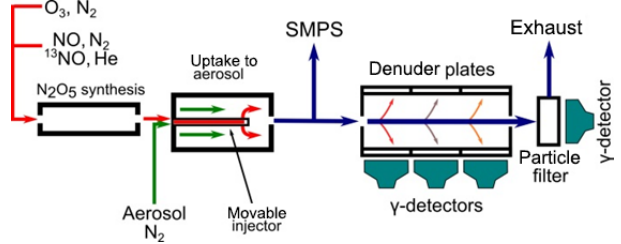
Figure 1. Schematic of the experimental